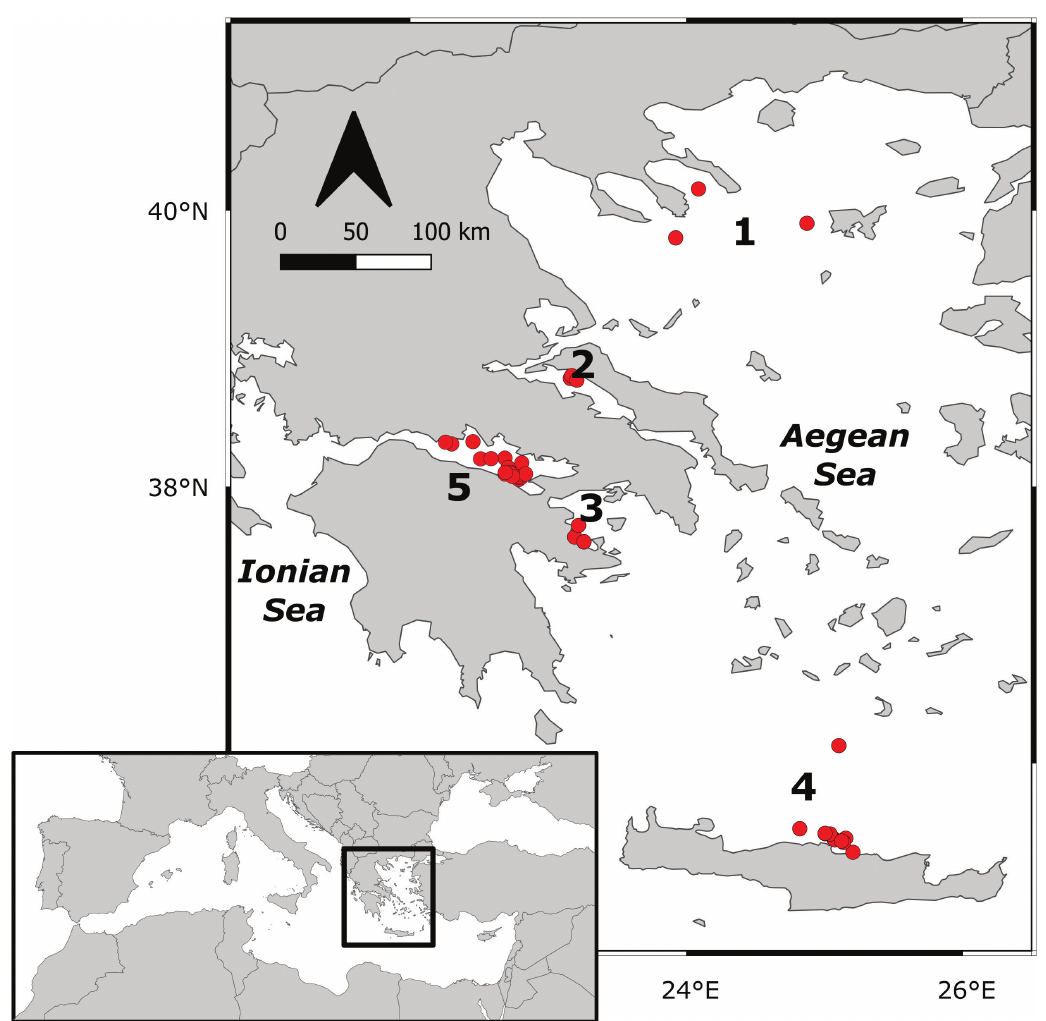
Figure 1. Sampling locations: North Aegean Trough (1), northern Euboean Gulf (2), Saronic Gulf (3), Cretan Sea (4), Gulf of Corinth Table 1. Length–weight relation parameters of 16 mesopelagic fish species sampled in Greek seas.